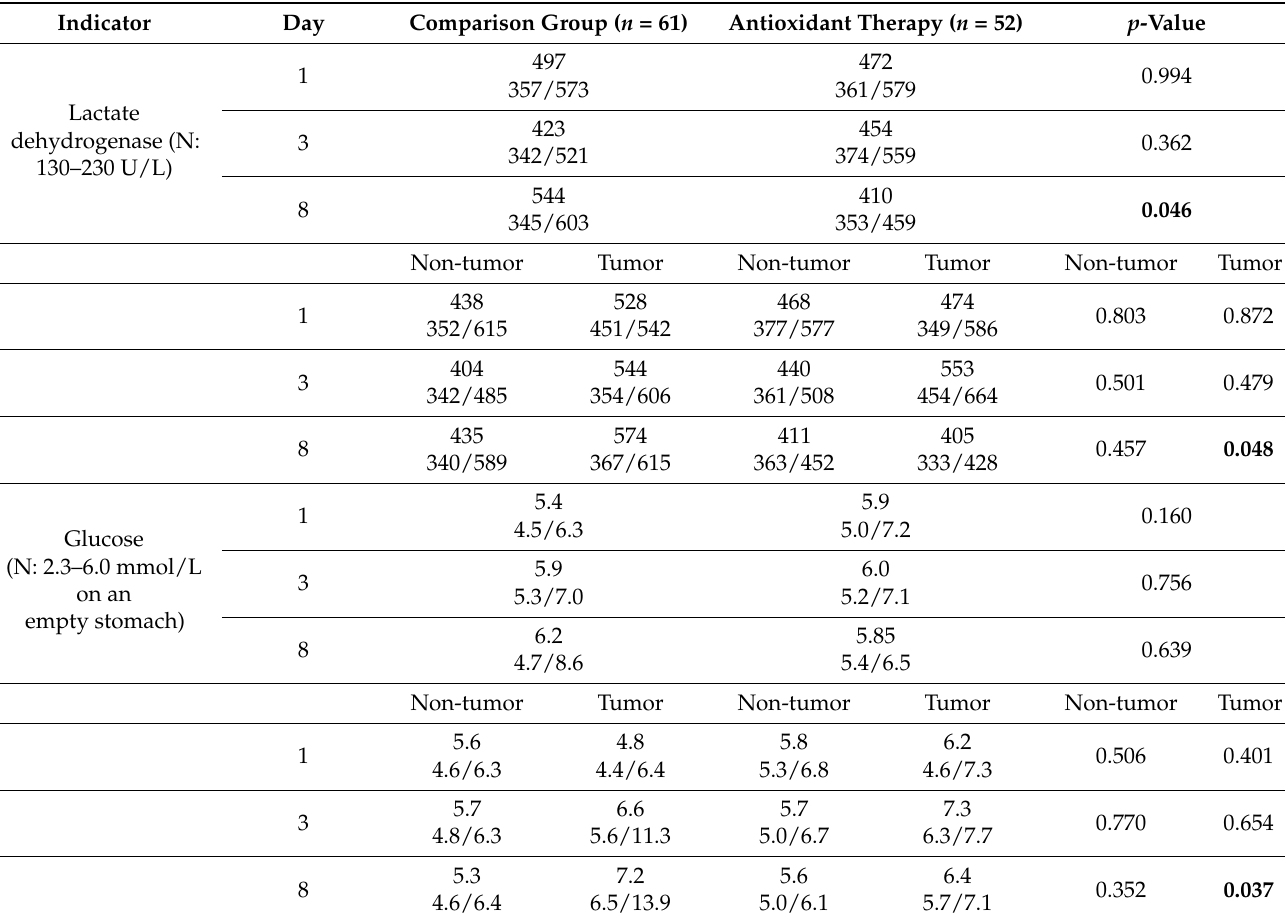
Table 5. Dynamics of lactate dehydrogenase and glucose changes in blood in patients with ob- structive jaundice of tumor and non-tumor origin, among those who received and did not receive antioxidant